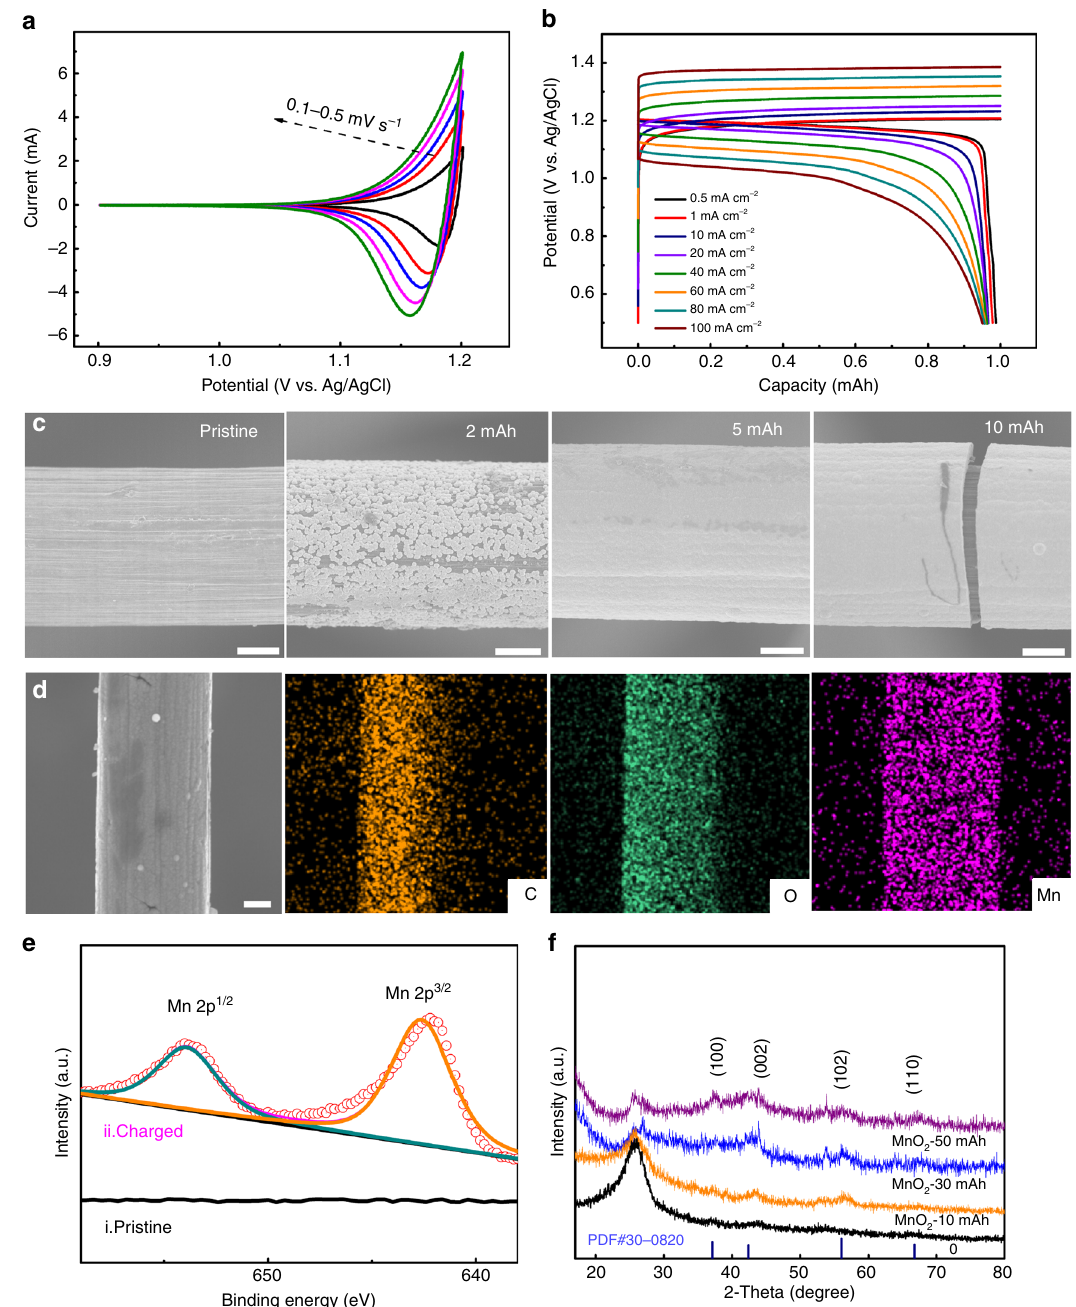
Fig. 3 Electrochemical performance and morphology characterization investigations of MnO 2 @GF cathode. a CV curves of GF-electrode at various scan rates from 0.1 to 0.5 mV s − 1 . b Galvanostatic discharge-charge pro fi les of GF-electrode at different current densities. c Morphology characterizations by SEM at pristine, 2 mAh, 5 mAh, and 10 mAh MnO 2 electrodeposition situations. Scale bar: 2 μ m. d SEM images and EDS-elemental mapping images with 5 mAh MnO 2 electrodeposition for GF-electrode. Scale bar: 2 μ m. e XPS spectra of Mn element on GF-electrode at (i) pristine state, and (ii) charged state with 5 mAh electrodeposition capacity using a charge current density of 5 mA cm − 2 . f XRD patterns for MnO 2 @GF cathode under various MnO 2 electrodeposition capacities (i.e., 0, 10 mAh, 30 mAh, 50 mAh, with an applied current density of 20 mA cm − 2 ). All above tests used 2 M MnSO 4 + 2 M H 2 SO 4 solutions as